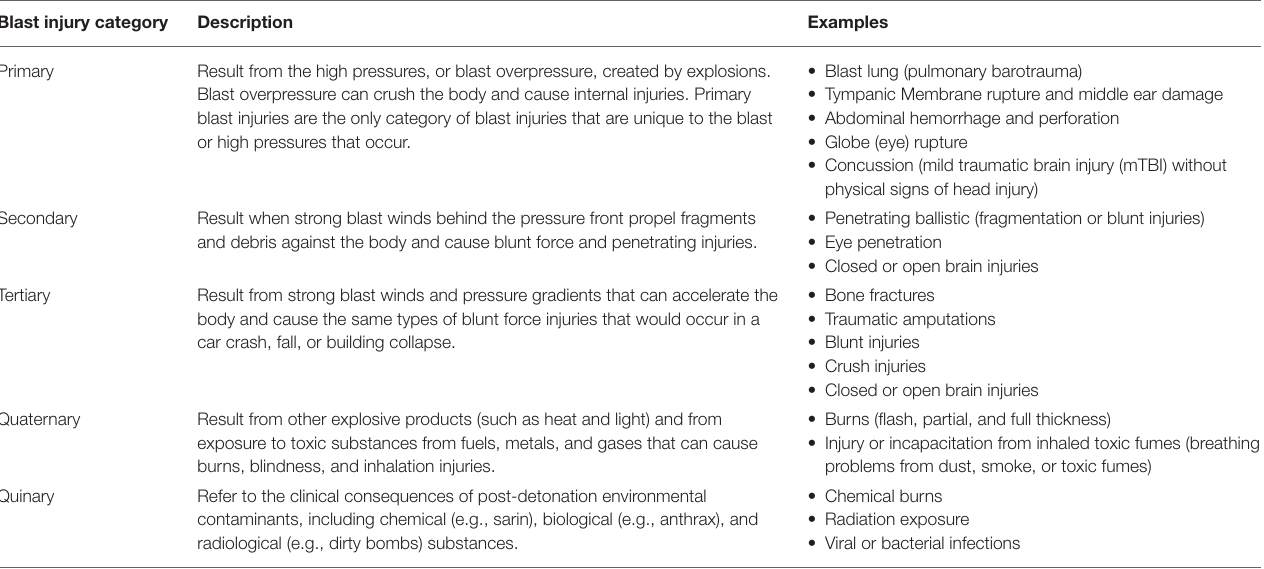
TABLE 1 | Taxonomy of injuries from explosive devices per DoD Blast Injury Research Coordinating